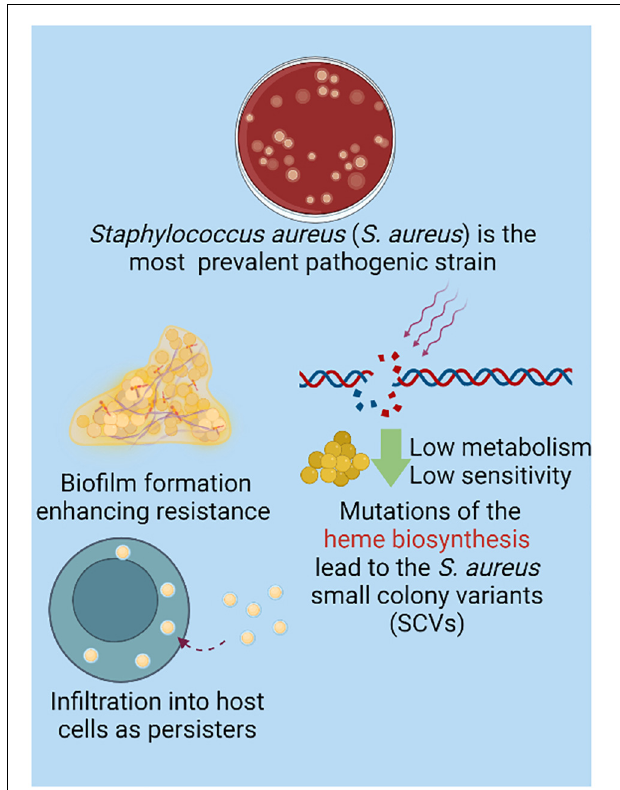
FIGURE 2 | Although species contribute to bone infection is in diversity, Staphylococcus aureus ( S. aureus ) is the most prevalent isolated strain (Wright and Nair, 2010). The biofilm formation significantly enhances the resistance of strains (Sanchez et al., 2013). With mutation of heme biosynthesis, small colony variant of S. aureus (SCV) is charactered by low metabolism which resulted in low sensitivity to the conventional antibacterial strategy. Interestingly, the intracellular SCV in host cells are causing the recurrent and refractory infective locus as persisters, which further provide the resistance of S. aureus (Proctor, 2019). Created with